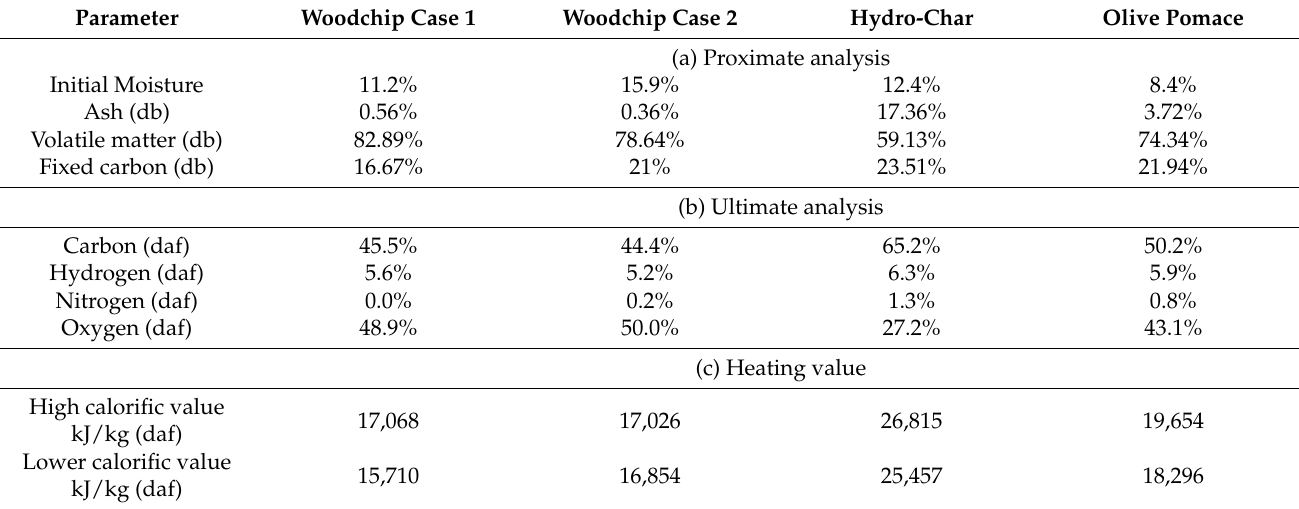
Table 4. (a) Proximate analysis, (b) ultimate analysis, (c) heating value for the four biomasses